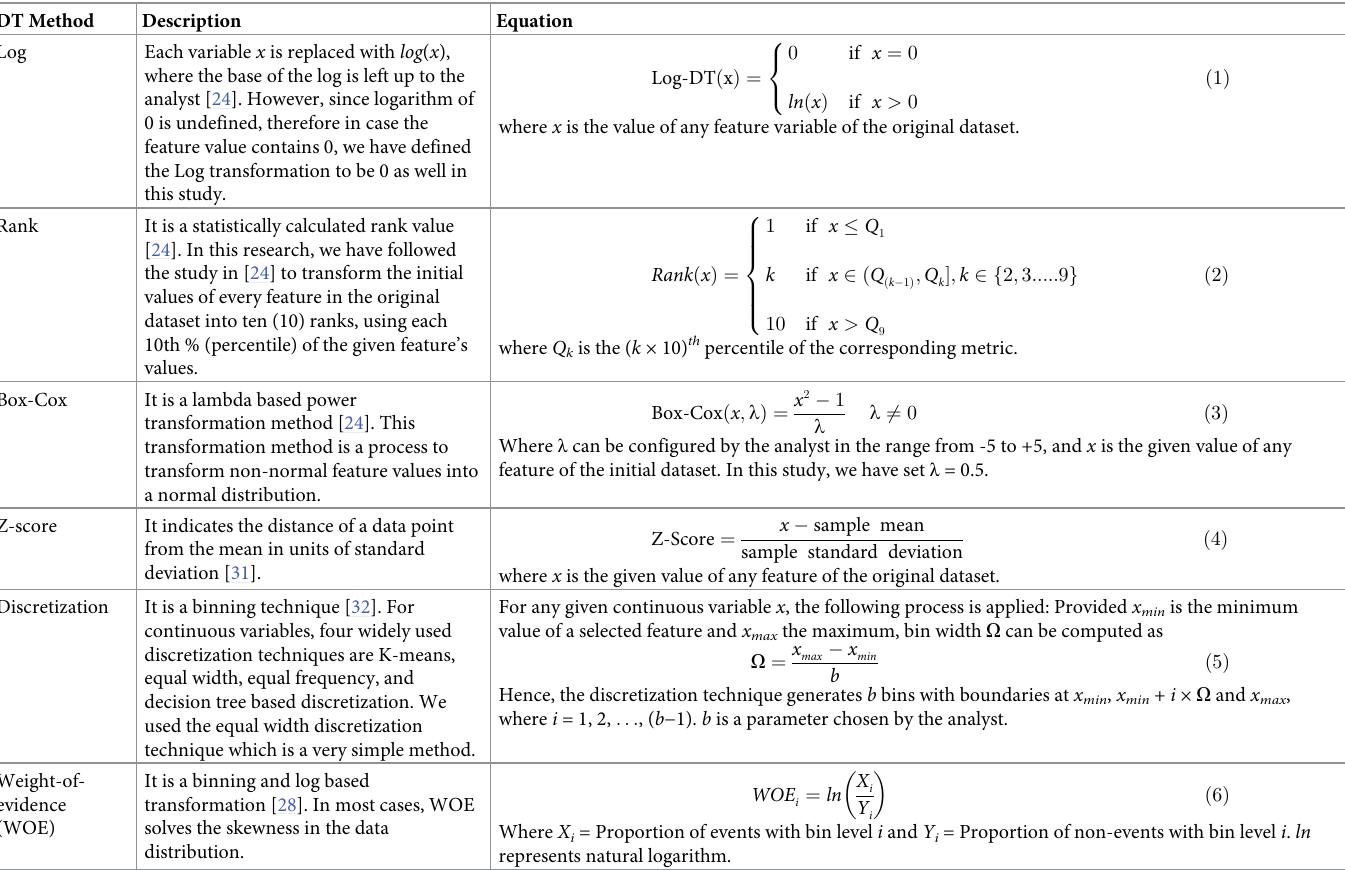
Table 3. List of data transformation methods. DT Method Description